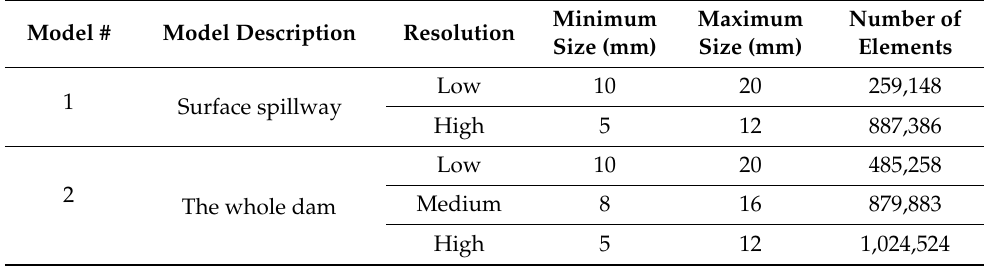
Table 3. Main features of the grids employed for both models.